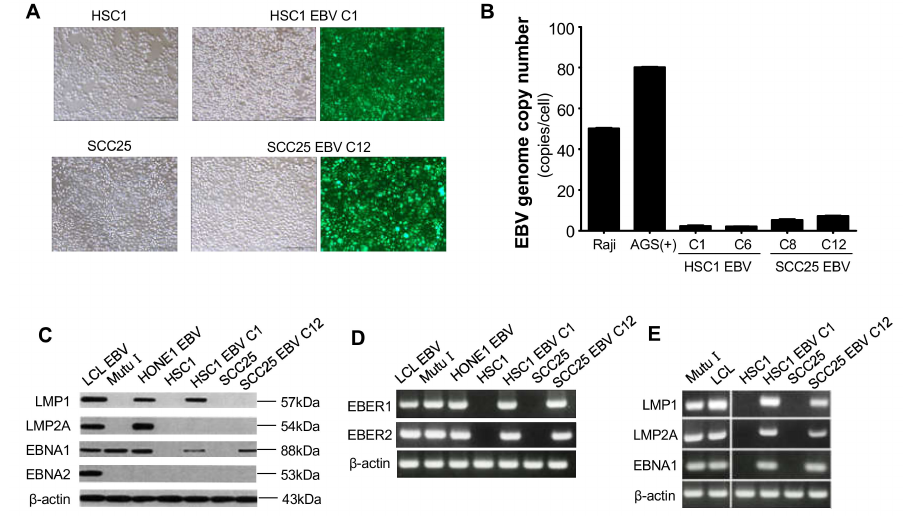
Figure 2. Characterization of EBV-infection in OSCC cells. Establishment of EBV-positive SCC cell lines by cell mediated infection ( A ). Quantification of EBV genome copy number by qPCR ( B ). EBV latency pattern examined by Western blotting ( C ). Expression of EBER1 and EBER2 by RT-PCR ( D ). Expression of LMP1, LMP2A, and EBNA1 by RT-PCR ( E ). Scale bar: 200 µ